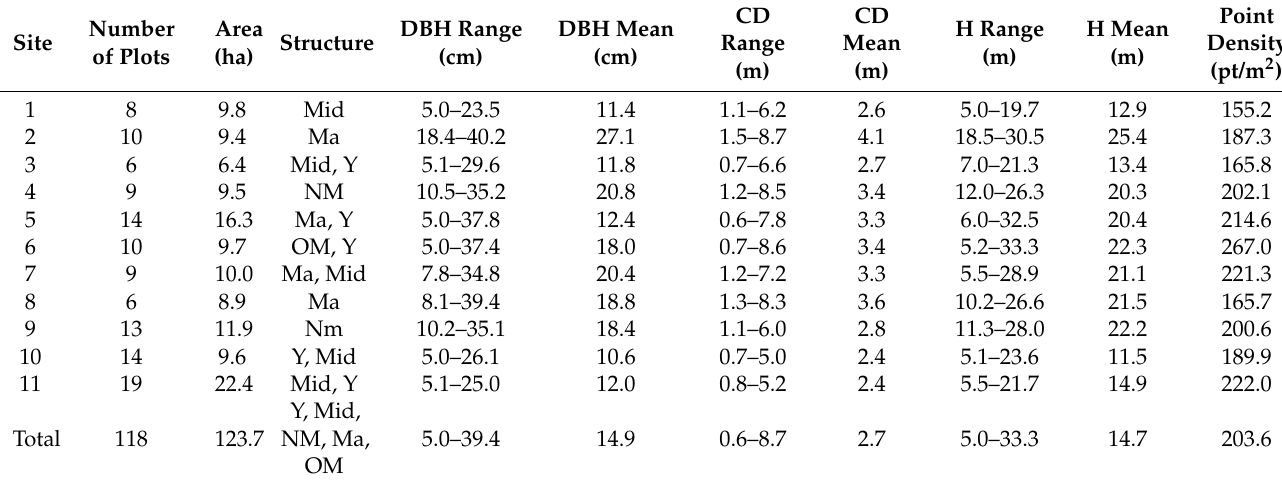
characteristics and UAVLS point densities are listed in Table 1 for each site. Table 1. Description of the forest characteristics and unmanned aerial vehicle laser scanning (UAVLS) data for a total of 11 sites.